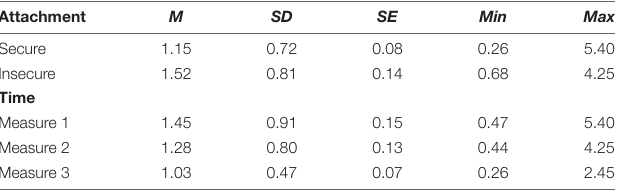
TABLE 6 | Descriptive statistics on main effects of attachment and time on cortisol measures in ng/ml. Attachment M SD SE Min Max Secure